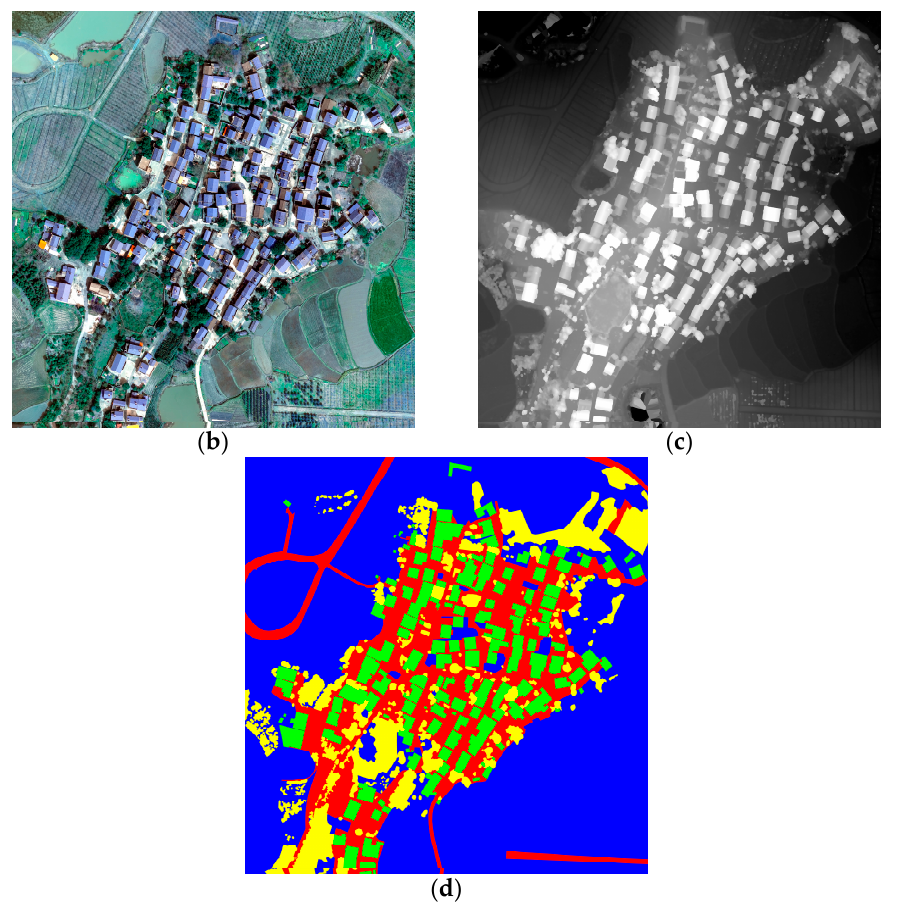
Figure 1. The LULC classification datasets in rural areas of Wuhan city. ( a ) Research location in Suohe Town, Caidian District, Wuhan City, Hubei Province, China; ( b ) high-resolution remote sensing image; ( c ) NDSM; and ( d ) ground truth (C1 Red: impervious surfaces; C2 Green: homestead; C3 Blue: background; C4 Yellow: trees).